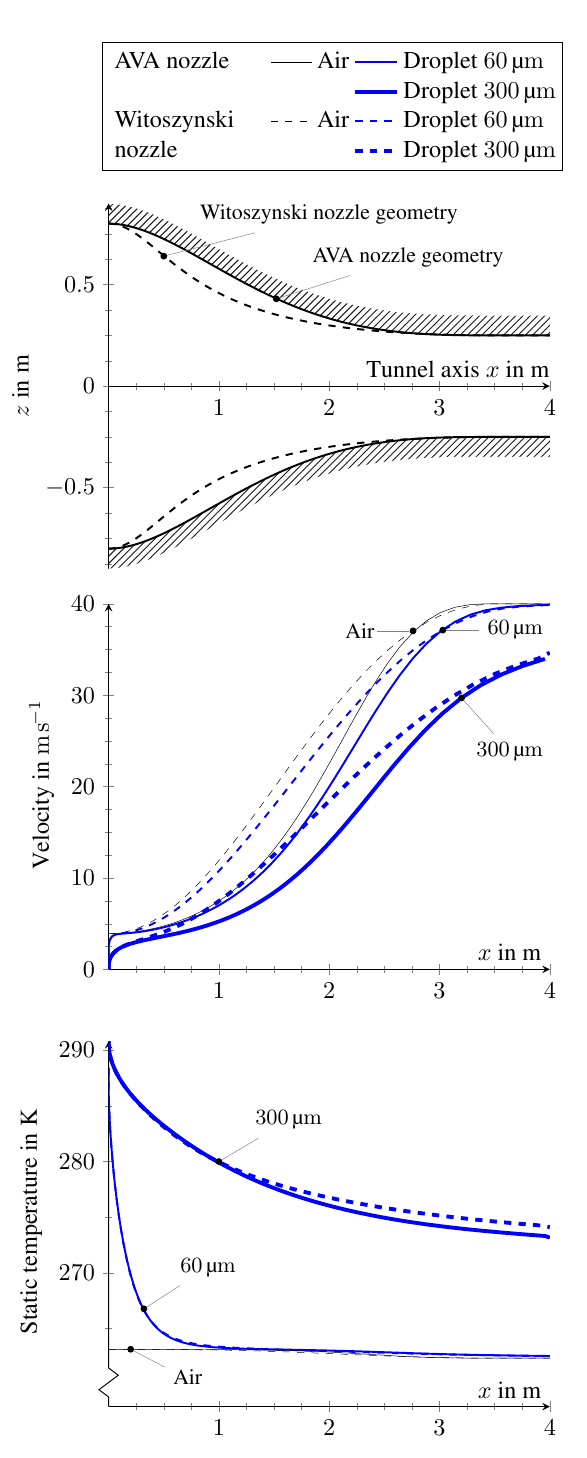
Figure 8. Velocity and temperature slope for air and two different sized droplets inside two tunnel nozzle configurations.